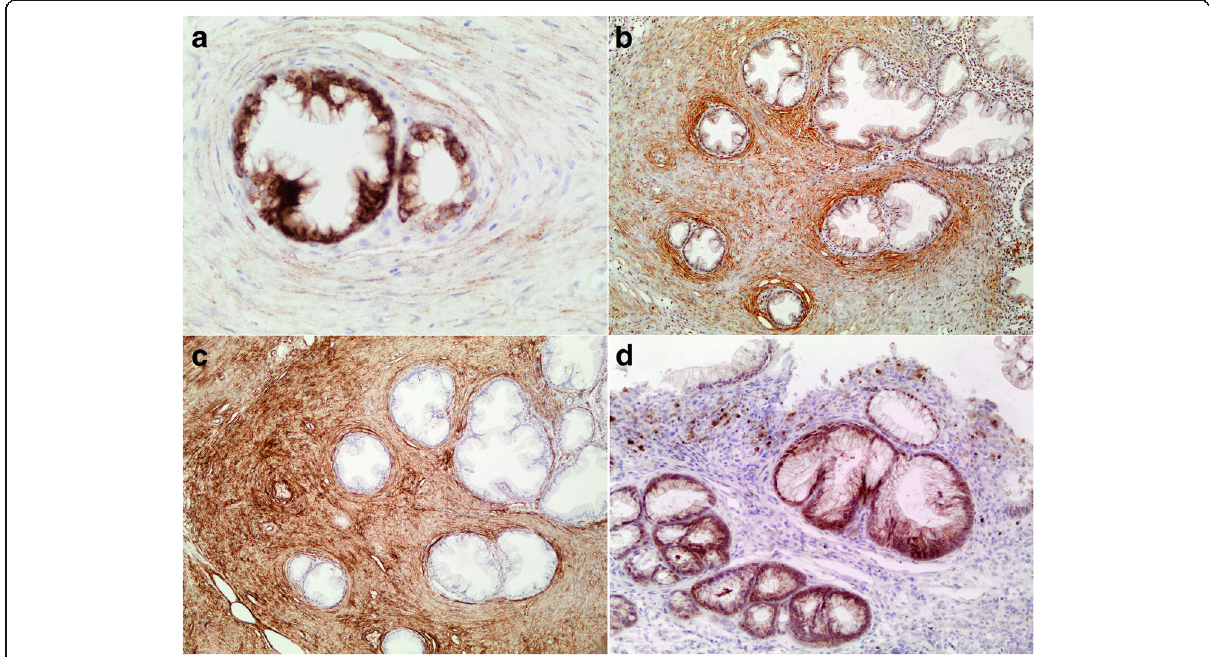
Fig. 2 Immunohistochemical findings. a Staining for EMA showed weak delicate staining in the stromal component compared to strong staining in the serrated crypts (original magnification 400×). b GLUT1 showed positive staining with pericryptic accentuation (original magnification 100×). c Moderate to strong staining was seen with collagen IV (original magnification 100×). d Staining for BRAF V600E showed cytoplasmic expression in serrated crypt epithelium but was negative in nonserrated crypts (nuclear staining only; uppermost crypt) and in the perineurial proliferation. The pigment in the lamina propria is hemosiderin (original magnification